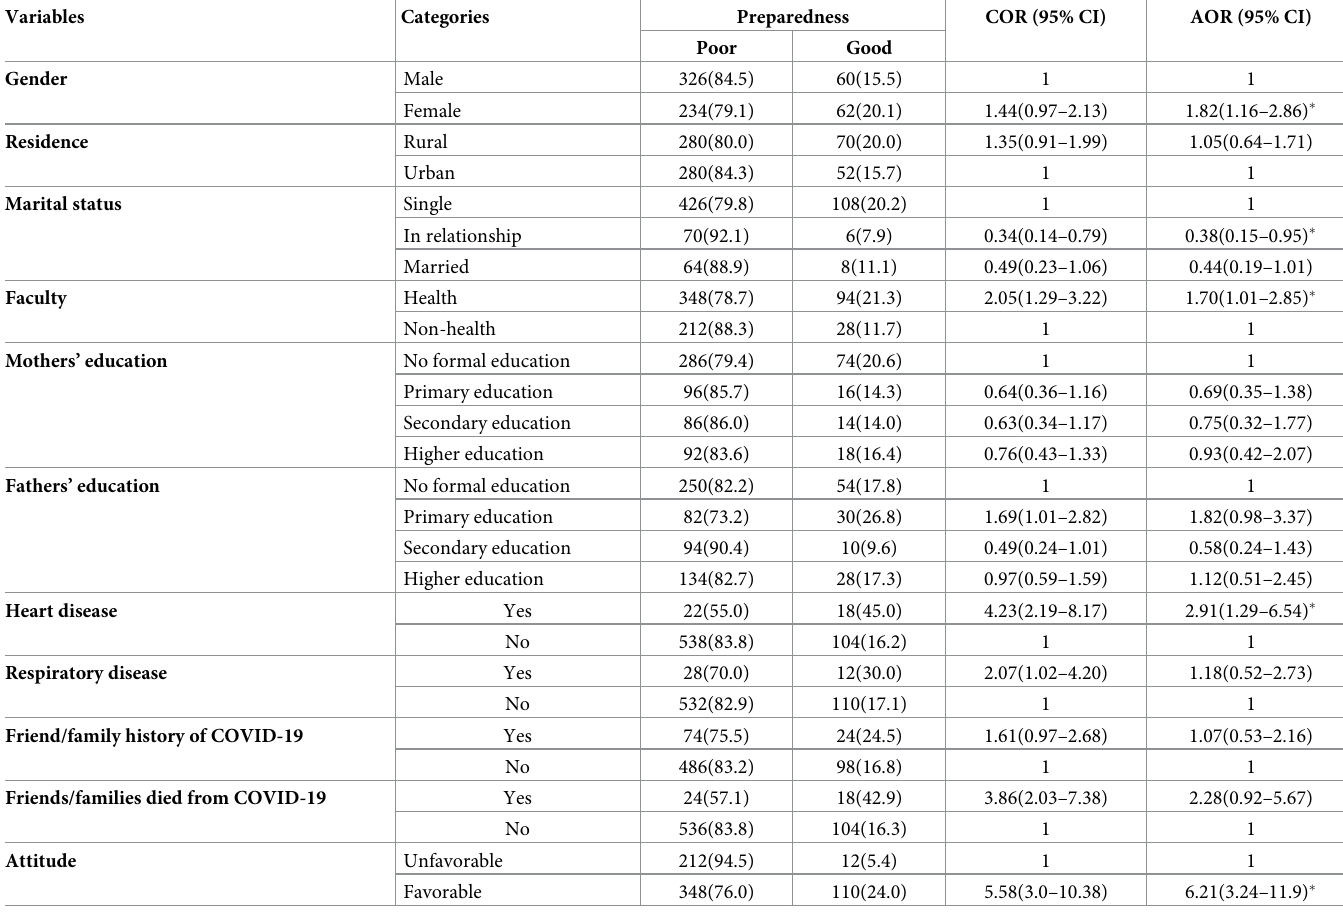
Table 7. Univariable and multivariable logistic regression analysis for preparedness to combat the spread of COVID-19 in DBU, Northeast Ethiopia,